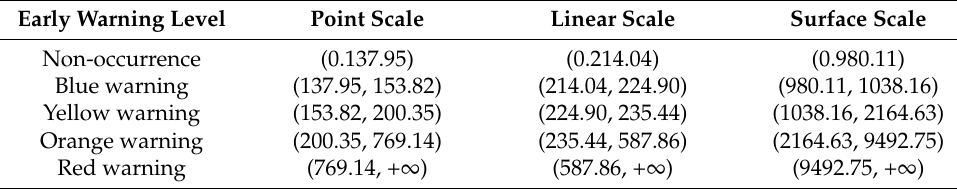
Table 3. The results of deformation threshold intervals with large scale (mm).